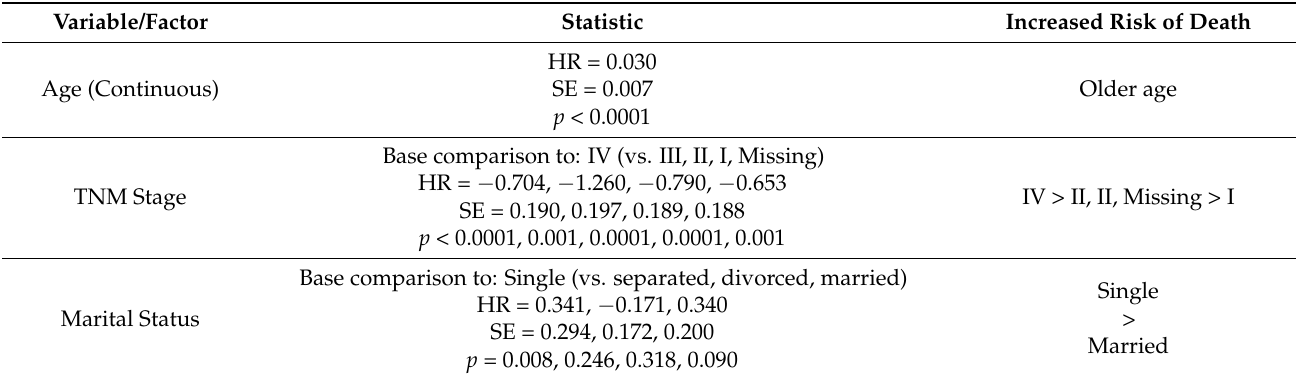
Table 10. Patient and tumor characteristics significantly predicting overall survival amongst laryngeal cancer patients by multivariable Cox proportional hazard model (n = 306).